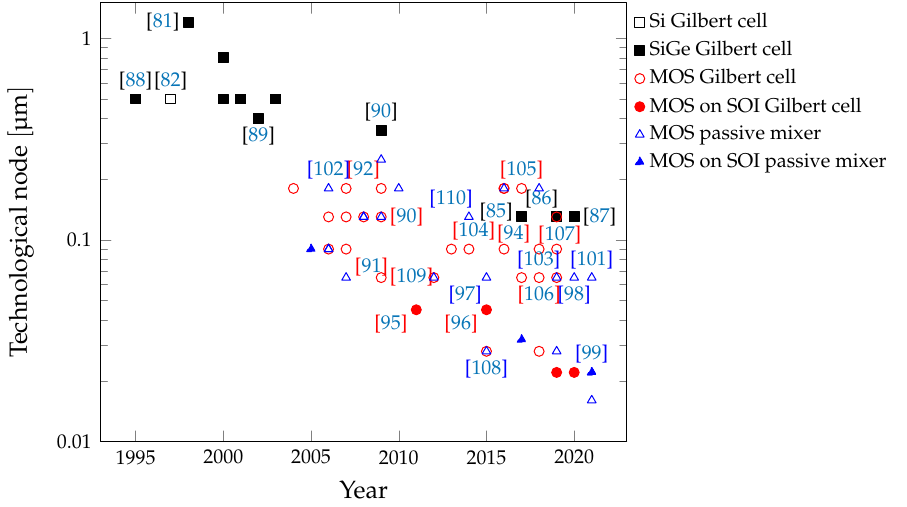
Figure 18. Mixers technological trends: technological node versus year of publication